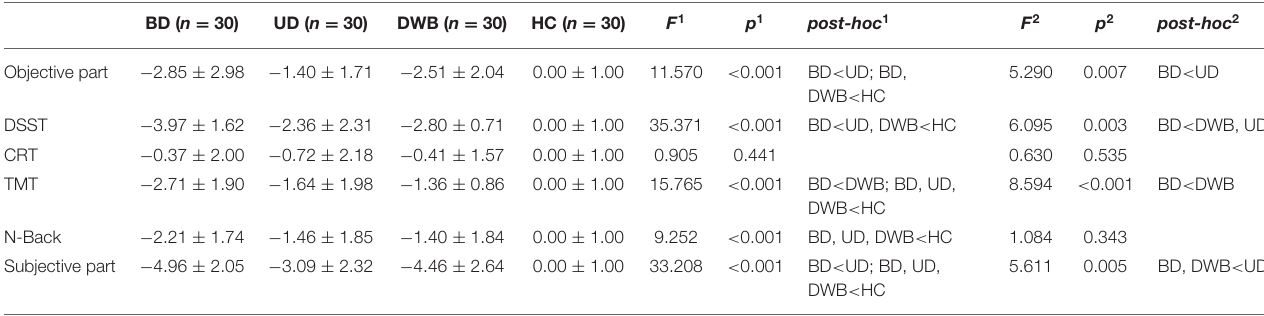
TABLE 2 | Comparison of THINC-it among patients with bipolar depression, unipolar depression, depression with bipolarity, and healthy controls (mean ±